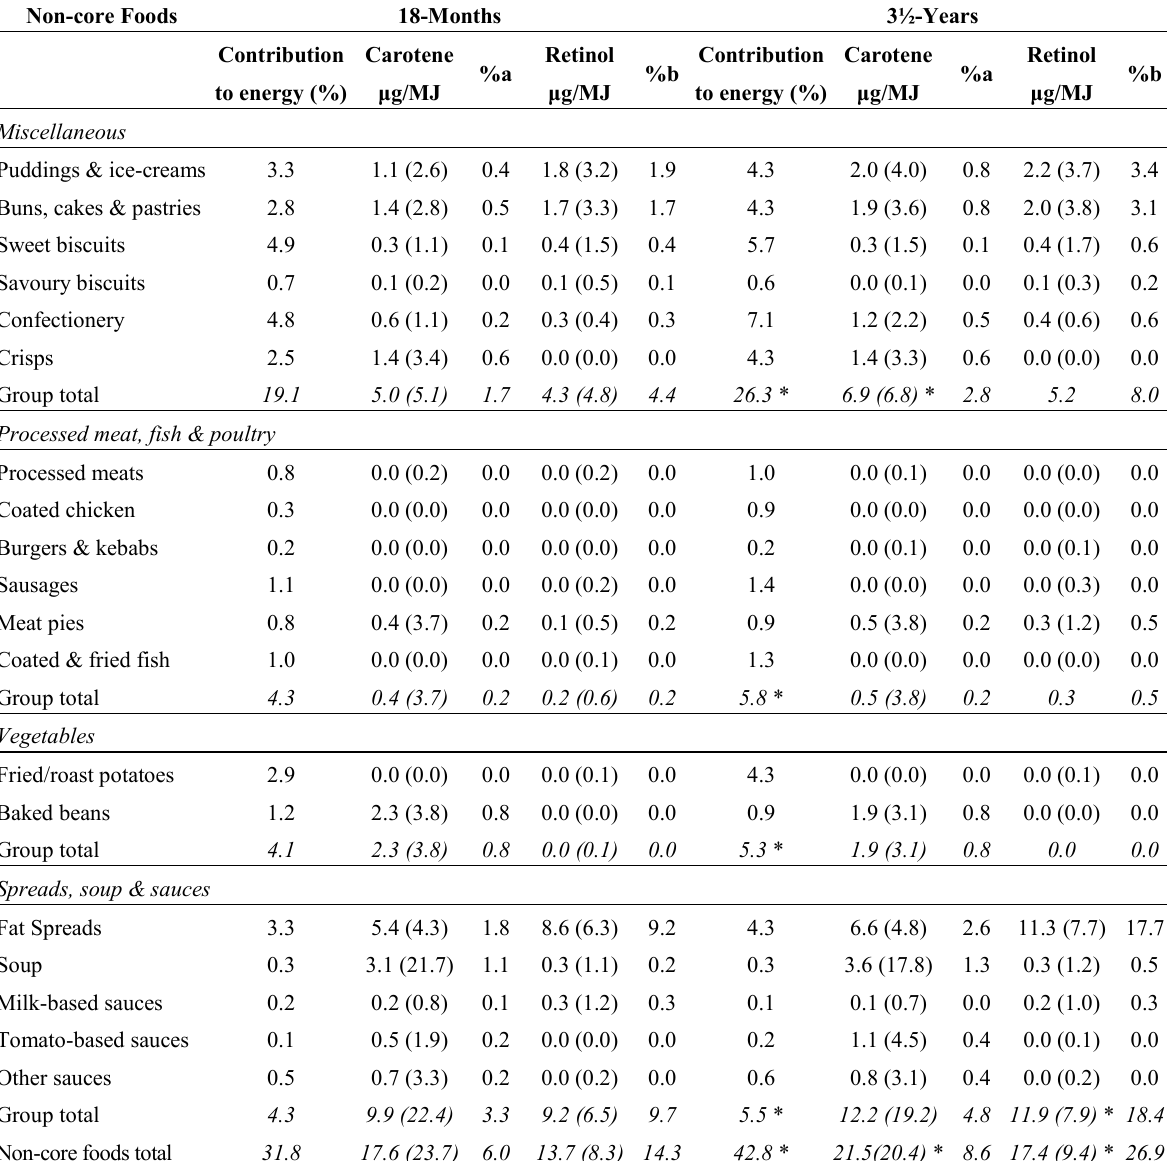
Table 3. Energy-adjusted carotene and retinol (mean (standard deviation) μg/MJ/day) and percentage contribution to energy of non-core food items in a cohort of children ( n = 755) at 18-months and 3½-years. Food group intakes of carotene and retinol compared between 18 months and 3½-years by paired t